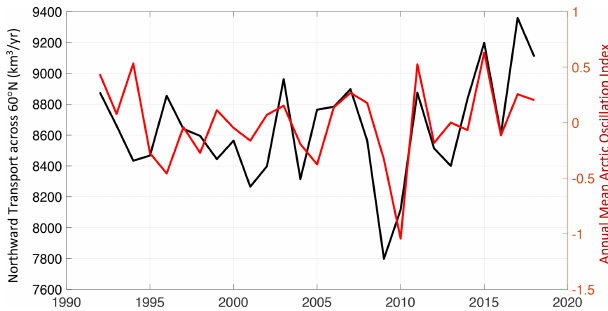
Figure 4. Time series of annual poleward atmospheric moisture transport (in km 3 yr − 1 ) across 60 ◦ N updated using the ERA5 re- analysis dataset following Zhang et al. (2013) and the annual mean Arctic Oscillation (AO) index constructed by NOAA Climate Pre- diction Center from 1991–2019. The transport was integrated from the surface to the top of the atmosphere and along 60 ◦